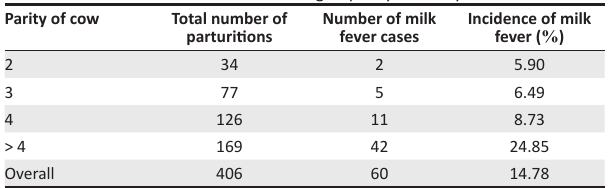
TABLE 2: Incidence of milk fever according to parity in Jersey cows.